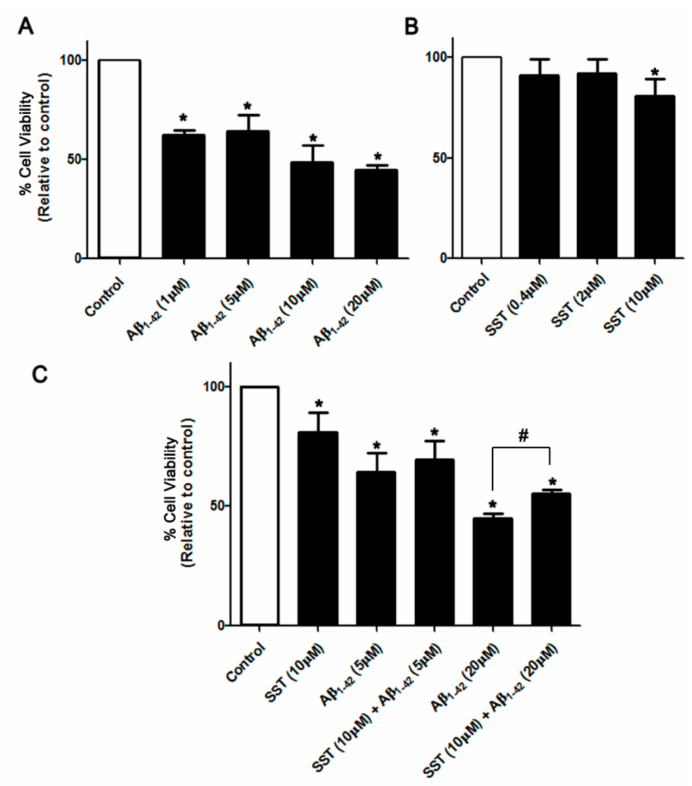
Figure 1. SST inhibits A β -induced cytotoxicity. Changes in cell survival following treatment with increasing concentrations of A β and SST alone or in combination were assessed by the MTT assay. ( A ) A β 1-42 induced dose-dependent toxicity in differentiated SH-SY5Y cells with maximal toxicity observed at 20 µ M of A β 1-42 . In contrast, SST displayed a marginal cytotoxic effect at higher doses only, without any significant effect at the lower concentrations ( B ). Cells treated with A β 1-42 (5 and 20 µ M) in combination with SST (10 µ M) displayed enhanced cell viability when compared to A β 1-42 alone ( C ). The data represent the mean ± SD of three independent experiments. * p < 0.05 against control; # against A β 1-42 (20 µ